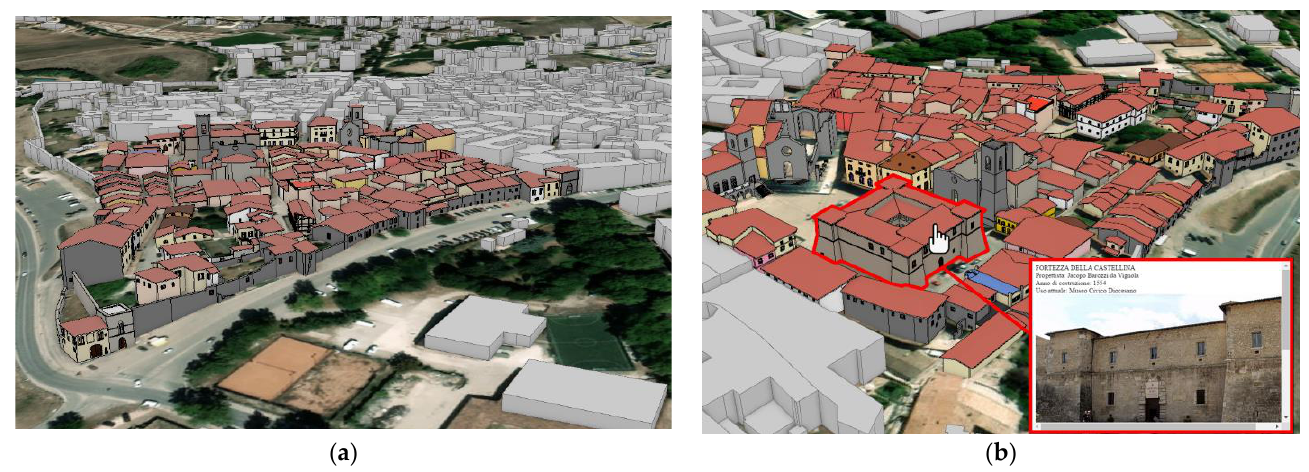
Figure 12. The Urban BIM related to Norcia city centre: the south-west part of the city ( a ), with a zoomed view on the Castellina 3D model and query in the 3D database ( b ).